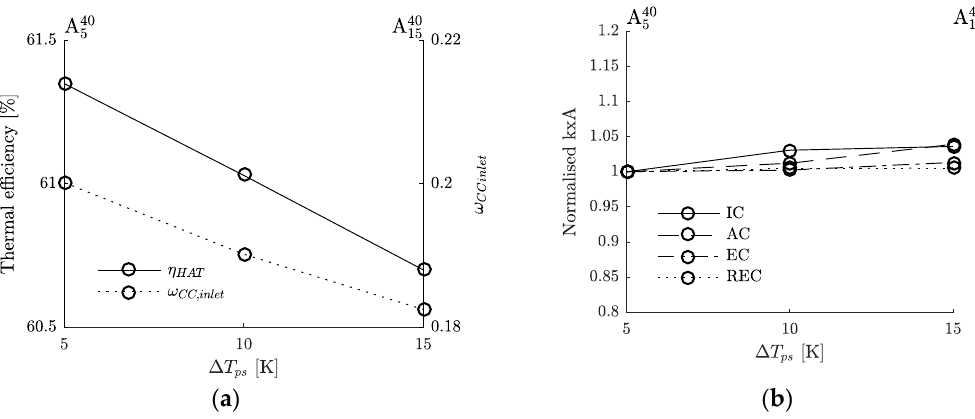
Figure 7. ( a ) saturator pinch temperature difference vs. cycle thermal efficiency and absolute humidity at the inlet of the combustion chamber ( (cid:1827) (cid:2873)(cid:2872)(cid:2868) → (cid:1827) (cid:2869)(cid:2873)(cid:2872)(cid:2868) ); ( b ) saturator pinch temperature difference vs. normalized k × A of each heat exchanger ( (cid:1827) (cid:2873)(cid:2872)(cid:2868) → (cid:1827) (cid:2869)(cid:2873)(cid:2872)(cid:2868) )—OPR = 40 & (cid:2013) (cid:3010)(cid:3004) = 0.95 & (cid:2013) (cid:3002)(cid:3004) = 0.95 & (cid:2013) (cid:3006)(cid:3004) = 0.95 & (cid:2013) (cid:3019)(cid:3006)(cid:3004) = 0.9.